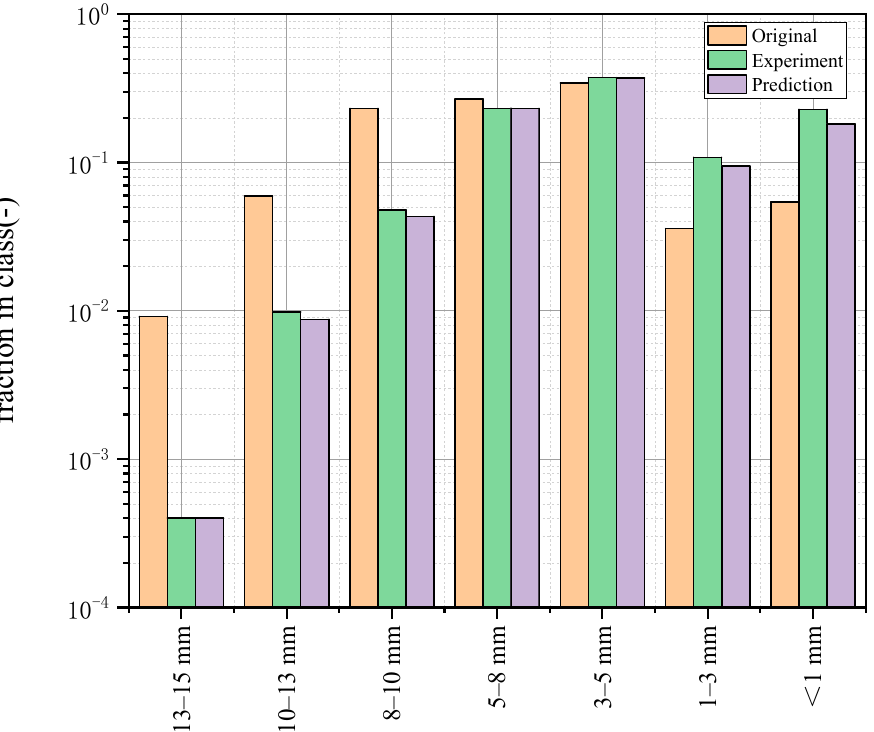
Figure 12. The predicted and experimental results of the PSD of nodules after running for 10 min (54 impacts) in the experimental system. (10 0 means that the percentage of particles of the size class is 100%, and 10 − 4 means that the percentage of particles of the size class is 0.01%).